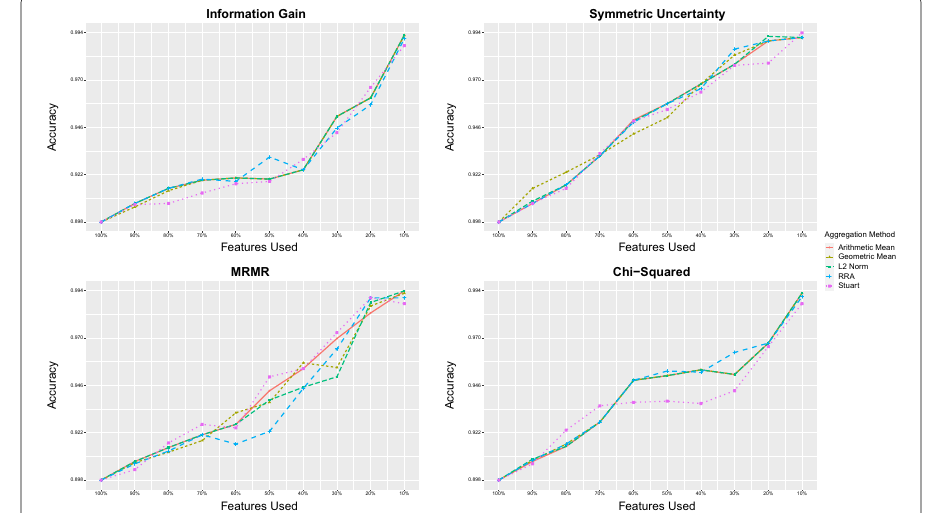
Fig. 10 Satellite dataset classification results